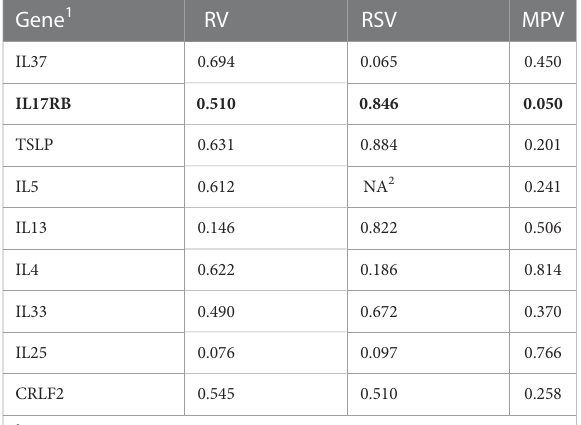
TABLE 6 Gene x virus interaction analysis results